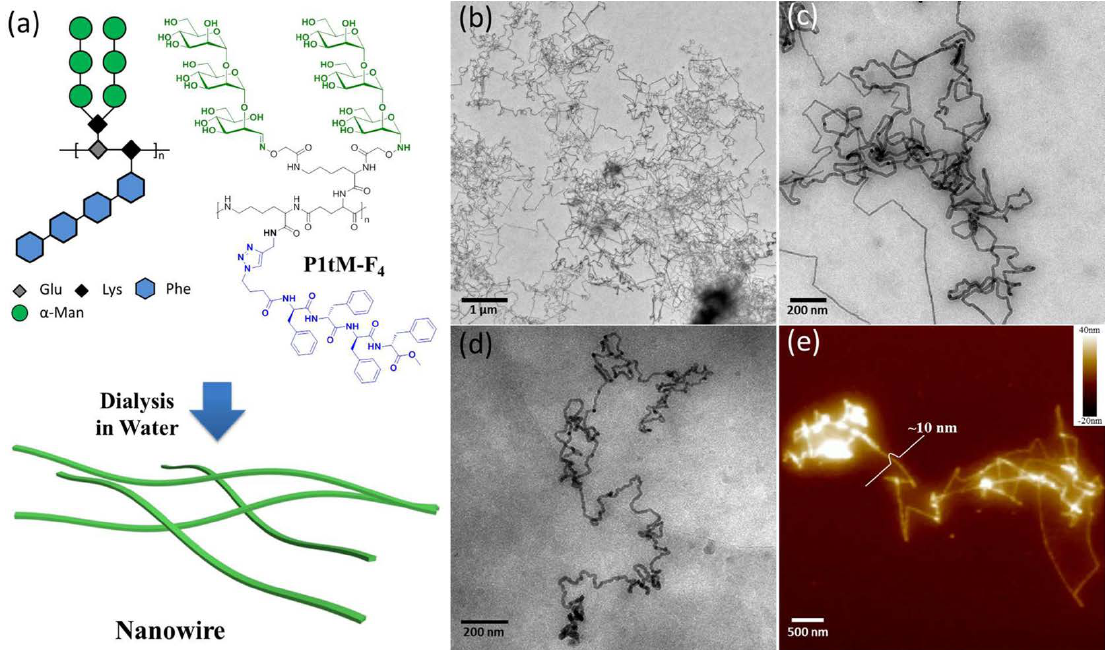
Figure 4. One variant of self-assembled micelle nanowires (P1tM-F 4 ) created from amphiphilic glycopolypeptide brushes in water. ( a ) Chemical structure and illustration of nanowires, ( b , c ) TEM images in different magnifications, ( d ) cryo-TEM image and ( e ) AFM image; as no alignment is performed on the nanowires, they deposit in a random configuration of disorder. Reprinted with permission from ACS